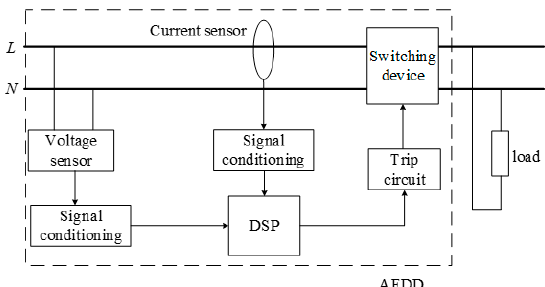
Figure 10. Hardware circuit diagram of arc fault detection device (AFDD).